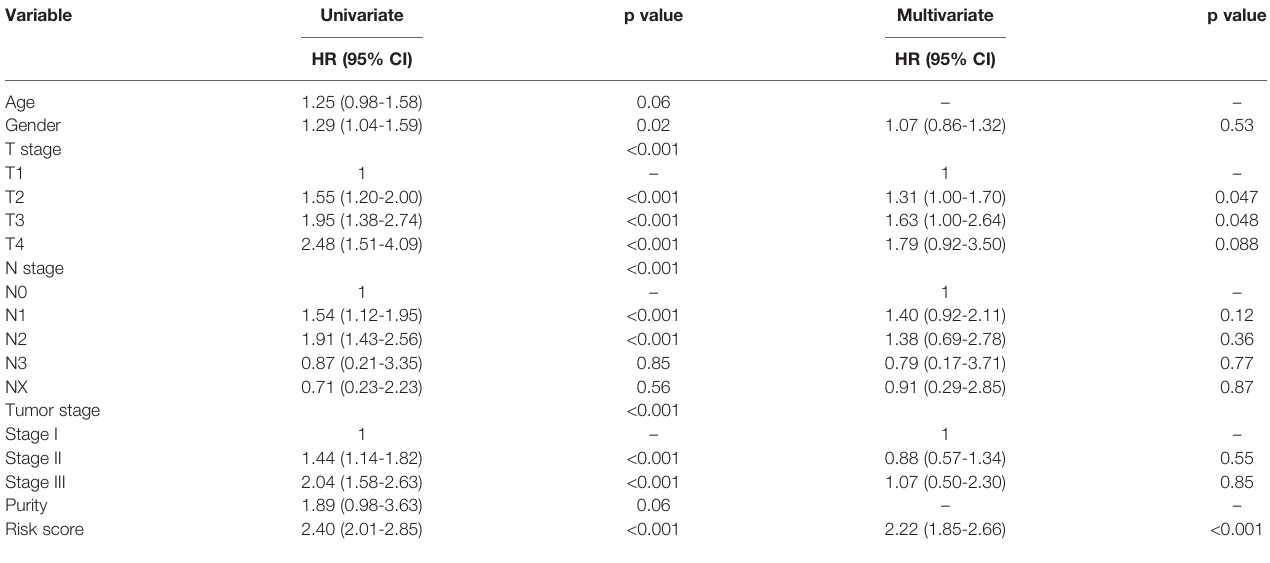
TABLE 2 | Univariate and multivariate analysis of clinical